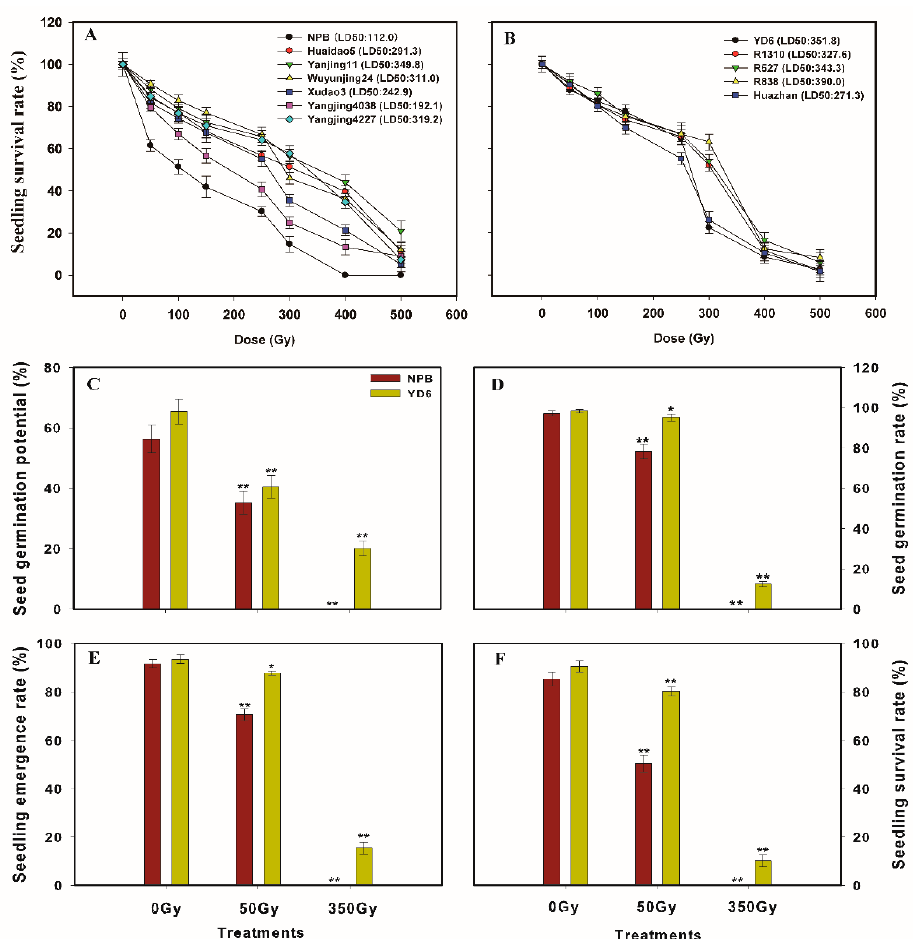
Figure 1. Germination profiles of japonica and indica rice at di ff erent irradiation dose. ( A ) Seedling survival rate of di ff erent japonica rice under di ff erent irradiation dose; ( B ) Seedling survival rate of di ff erent indica rice under di ff erent irradiation dose; ( C ) Seed germination potential of japonica rice Nipponbare (NPB) and indica rice Yangdao6 (YD6) under di ff erent irradiation doses; ( D ) Seed germination rate of NPB and YD6 under di ff erent irradiation dose; ( E ) Seedling emergence rate of NPB and YD6 under di ff erent irradiation dose; ( F ) Seedling survival rate of NPB and YD6 under di ff erent irradiation doses. There are three biological replicates and each biological replicate contains one hundred seeds. LD50, 50% lethal dose; Bars are mean ± SD of three independent biological replicates, and asterisks indicate significant di ff erence (*, p ≤ 0.05; **, p ≤ 0.01) compared to control (0 Gy).